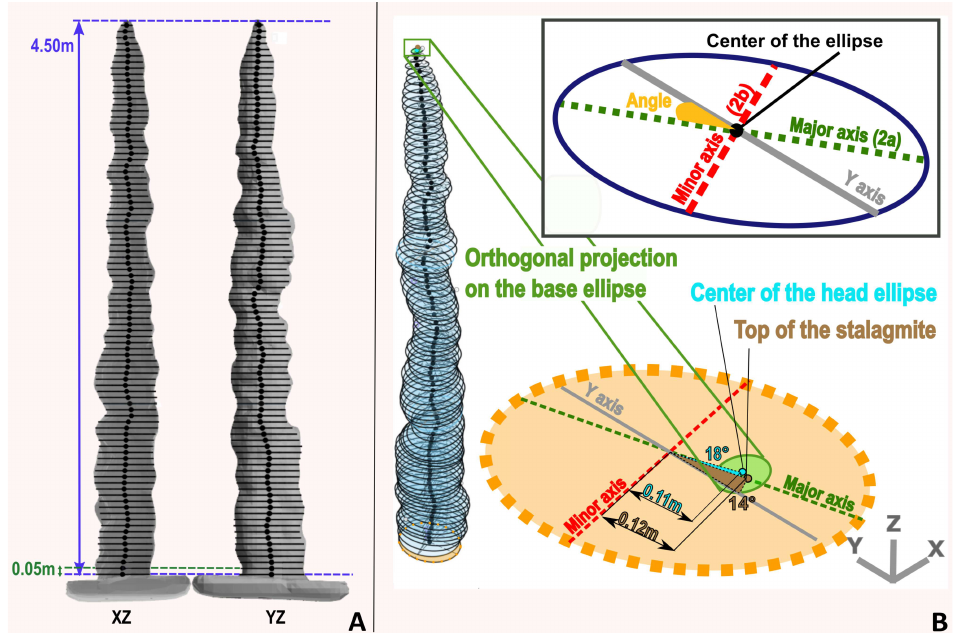
Figure 7. Shape and o ff set analysis of the 3D scan of the Minaret stalagmite: ( a ) orthogonal projections of the 3D scan on XZ and YZ planes with the elliptical cross-section (5 cm spacing) and the center of the ellipse (black dot); ( b ) representation of the principal parameters of the elliptical cross-sections and result of the o ff set analysis with the elliptical cross-sections.